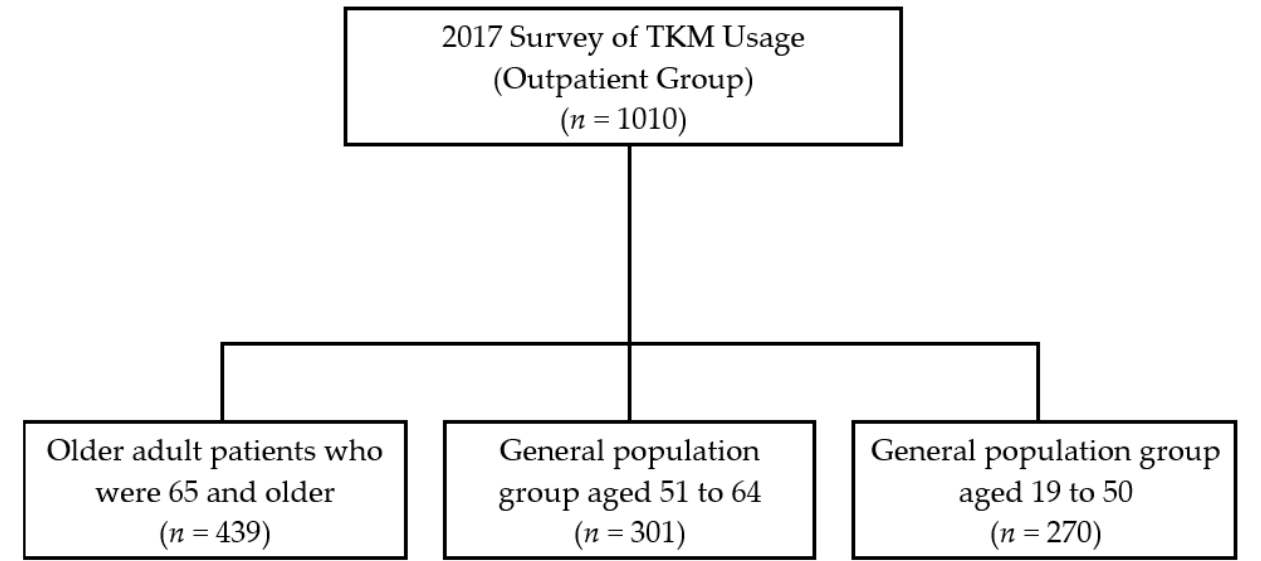
Figure 1. Flow chart of inclusion and exclusion of participants from the 2017 National Survey of TKM Usage. TKM: Traditional Korean Medicine.